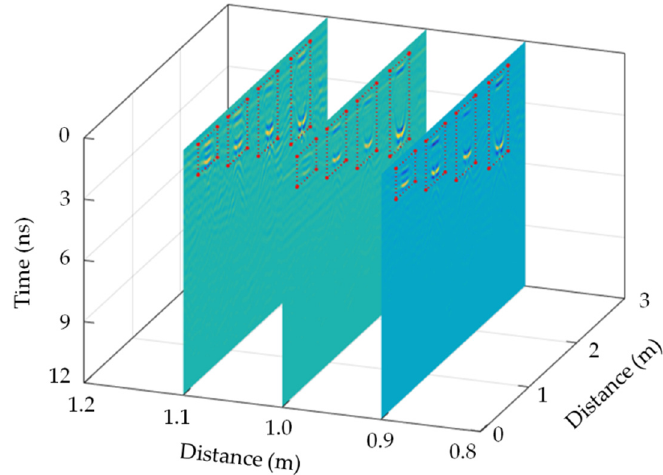
Figure 9. Slice chart formed by three longitudinal survey lines.